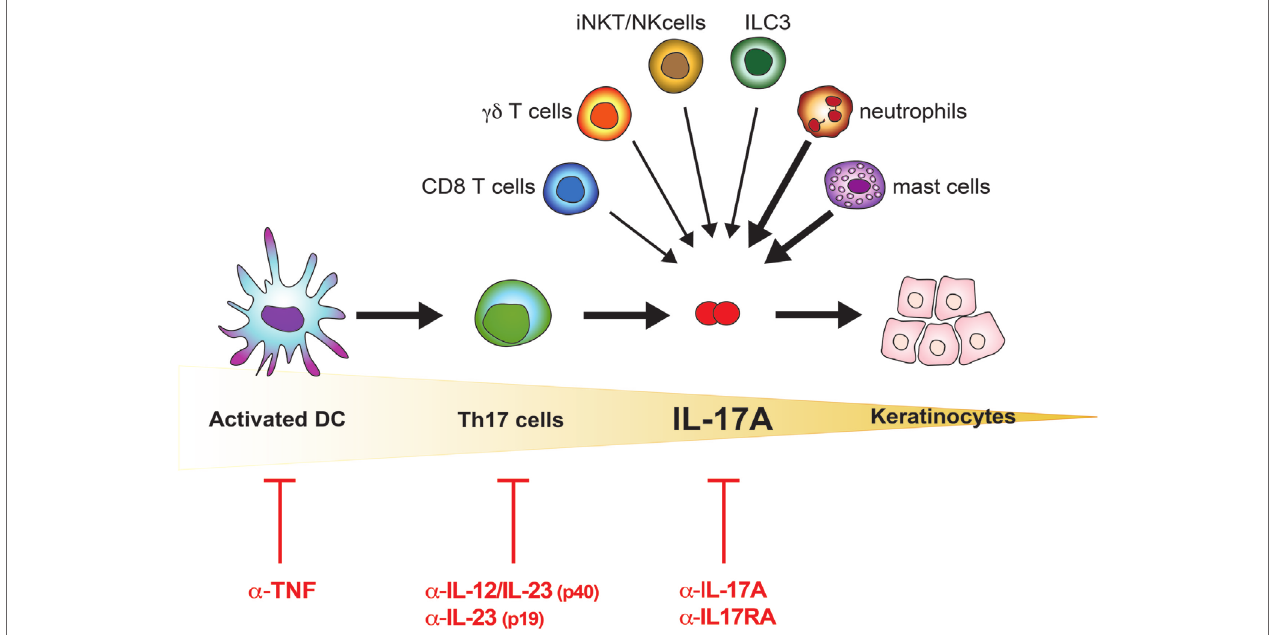
FigURe 1 | IL-17A in the pathogenesis of psoriasis. Schematic representation of the increasingly accurate selection of therapeutic targets in psoriasis. The cells possibly contributing to the bulk of IL-17A in lesional psoriatic skin are shown. Bolded arrows indicate higher contribution to IL-17A production in psoriatic lesional